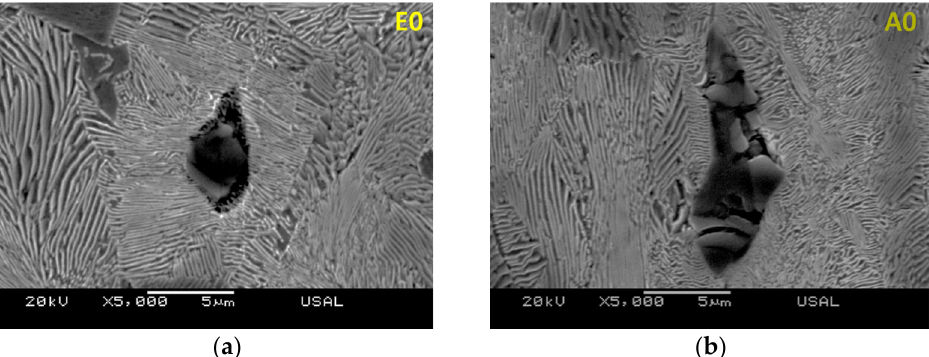
Figure 8. Inclusions in the longitudinal section of hot rolled pearlitic steels E0 and A0 ( zero degree of cold drawing ) showing oxides ( a ) and sulfurs ( b ).